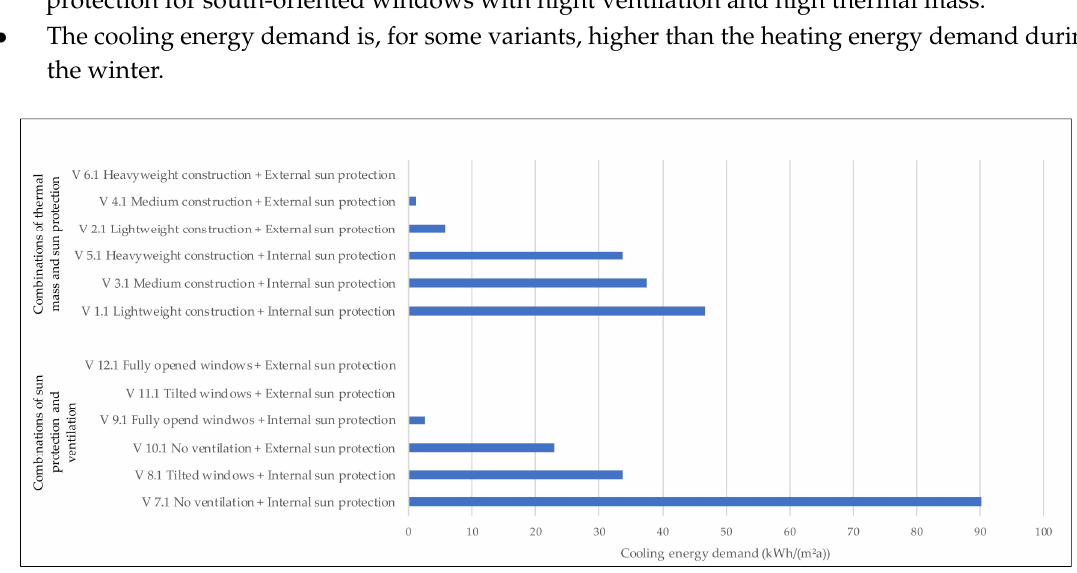
Figure 8. Current climate scenario—Cooling energy demand, based on [33].